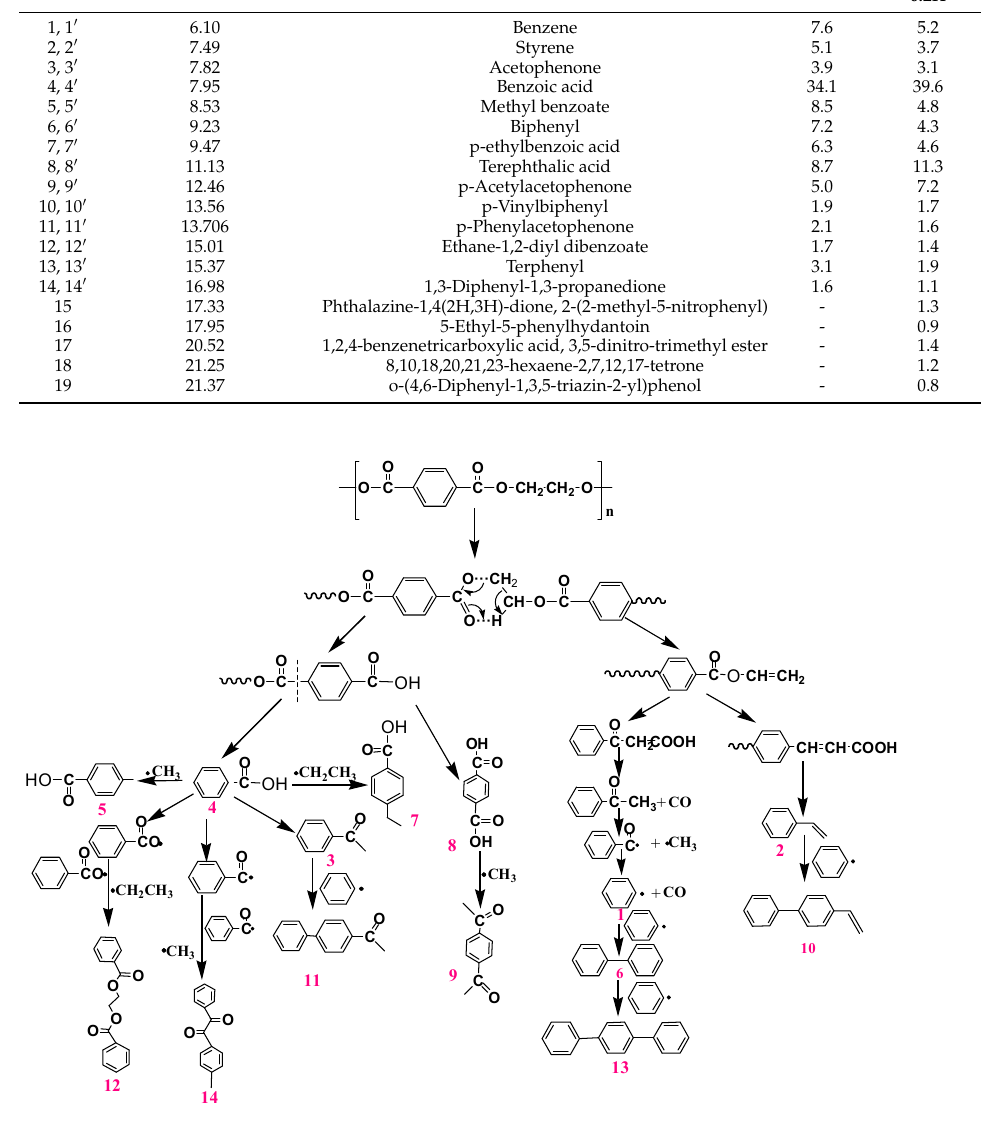
Figure 10. Proposed pyrolysis processes for PET. Compared with neat PET, the pyrolysis products after the addition of the 0.4G-0.2H represents some differences in the relative concentrations and composition. The pro- posed pyrolysis process for PET-0.4G-0.2H is shown in Figure 11. The main pyrolysis products were 39.6% Benzoic acid, 11.3% Terephthalic acid 7.2% p-Acetylacetophenone, 5.2% benzene, 4.8% Methyl benzoate, 4.6% Terephthalic acid, 4.3% Bibenzene, 3.7% Sty-